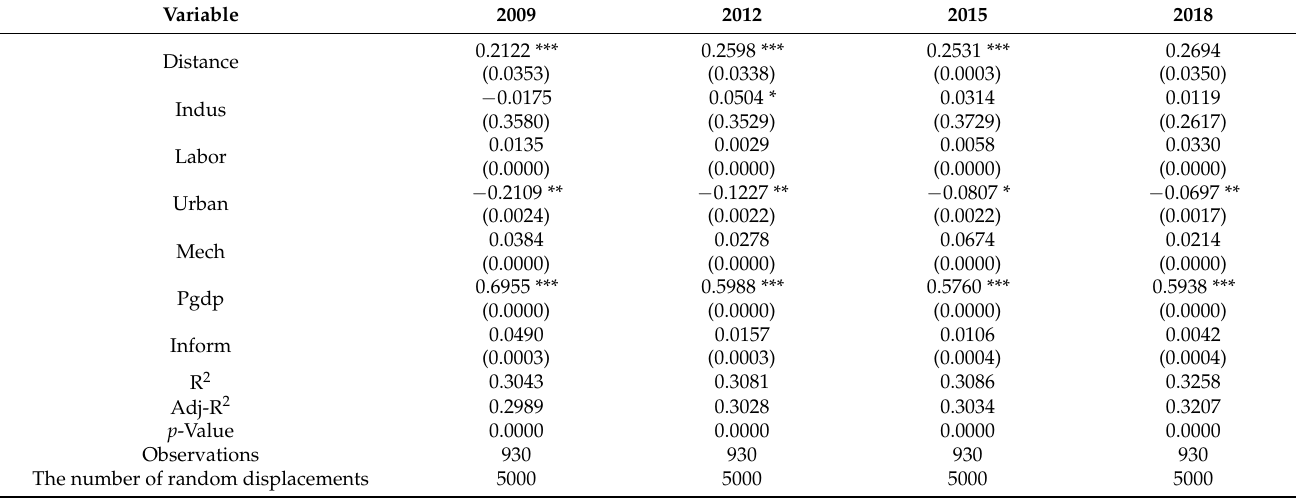
Table 10. The results of the regression of the drivers of the spatial